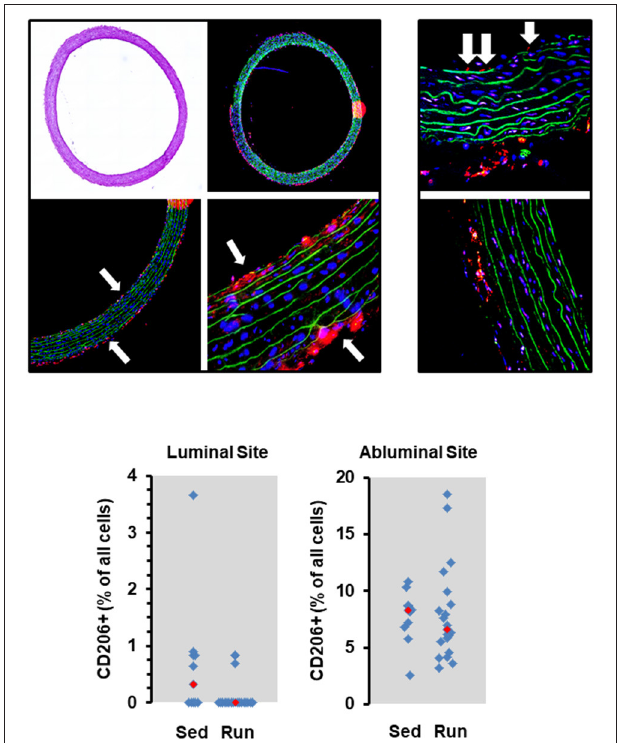
FIGURE 2 | Histological cross sections from aortae of normotensive rats and the effect of 10 months voluntary running wheel activity. Top left: Overview of an aorta by light microscopy, confocal laser microscopy, and two different magnifications used to count the number of CD206 + cells (in red) normalized to the total cell number as calculated by DAPI-stained nuclei in blue, and lamina elastic (in green). Top right: Examples of intraluminal located CD206 + cells (white arrows) from sedentary rats and from rats after 10 months running wheel activity. Bottom: Quantification of different slices from n = 5 rats each group. Red rectangles indicate the median, blue rectangles individual data